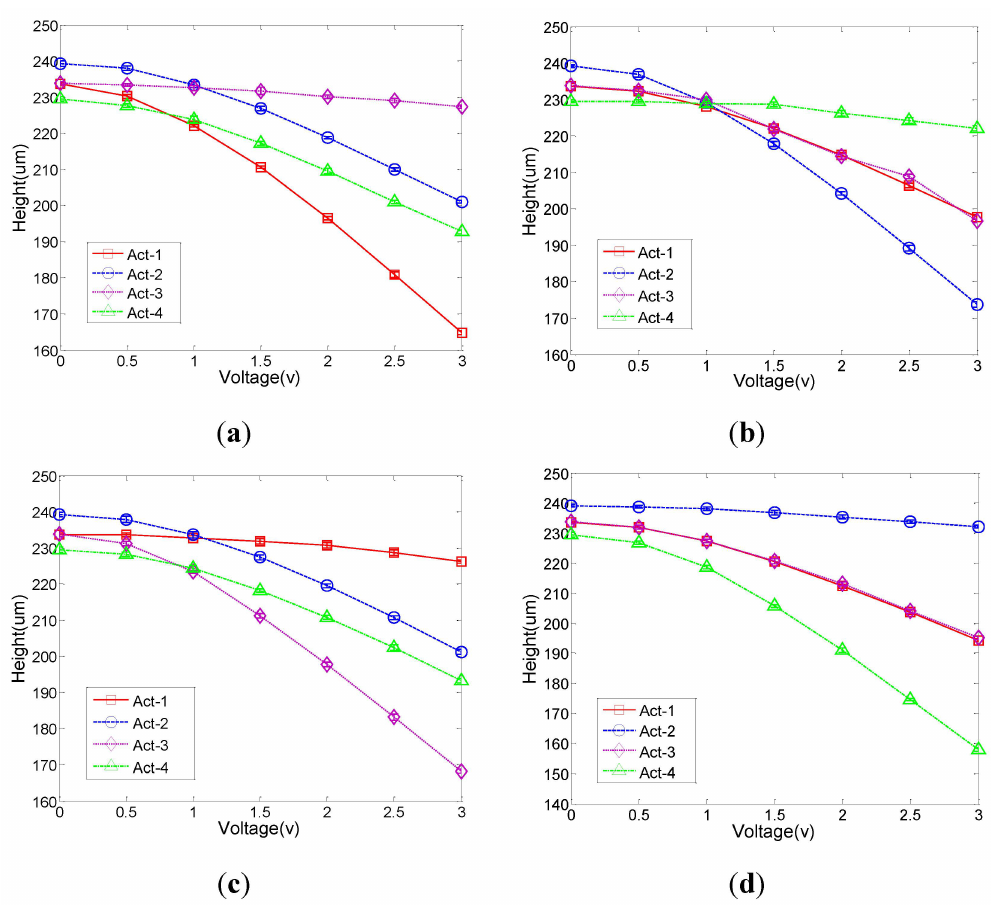
Figure 4. Height versus applied voltage. The voltage was applied to only one actuator. The heights of all four actuators were measured: ( a ) Only Actuator (ACT) 1 is active; ( b ) Actuator (ACT) 2 only; ( c ) Actuator (ACT) 3 only; and ( d ) Actuator (ACT) 4